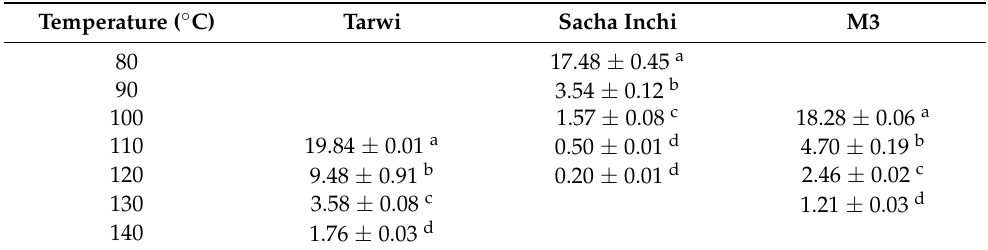
Figure 1. Oxidative stability index (OSI) at 120 °C of tarwi oil, sacha inchi oil and their blends. Tarwi oil: Sacha inchi oil ratios ( w / w ): M1 1:4; M2 1:3, M3 1:1; M4 3:1; M5 4:1. Different letters (a–e) indicate significant differences between samples at p ≤ 0.05 ( n = 3). Table 2. Mean ( ± standard deviation) oxidative stability index (h) of tarwi oil, sacha inchi oil and their 1:1 blend